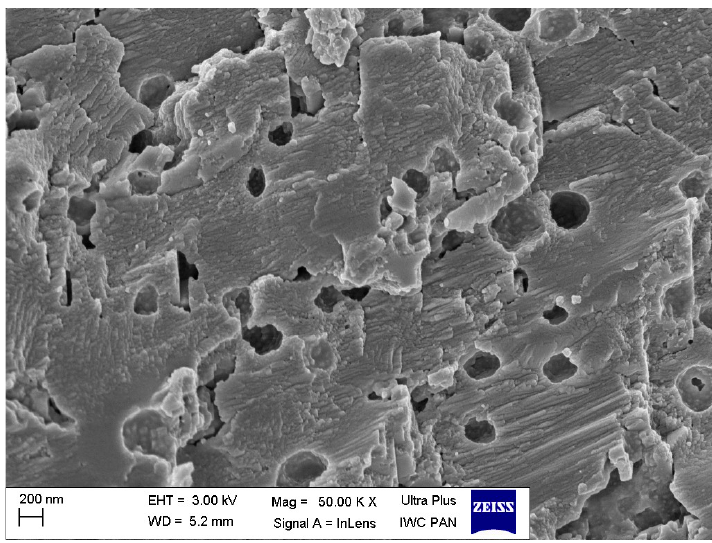
Figure 5. Scanning electron microscopy (SEM) image of the pure ground eggshells.